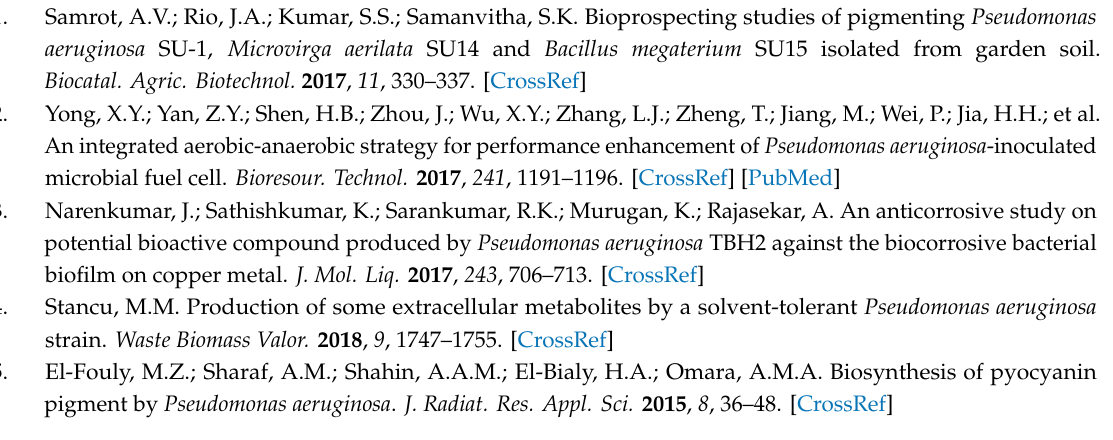
Table S1: Experimental design matrix for biomass and PYO production in the defined culture medium, Figure S1: (a) Chromatograms and absorption spectra of PYO standard and (b) PYO extracted from Pseudomonas aeruginosa NEJ01R culture supernatant, Figure S2: (a) Mass spectra of PYO standard and (b) PYO extracted from Pseudomonas aeruginosa NEJ01R culture